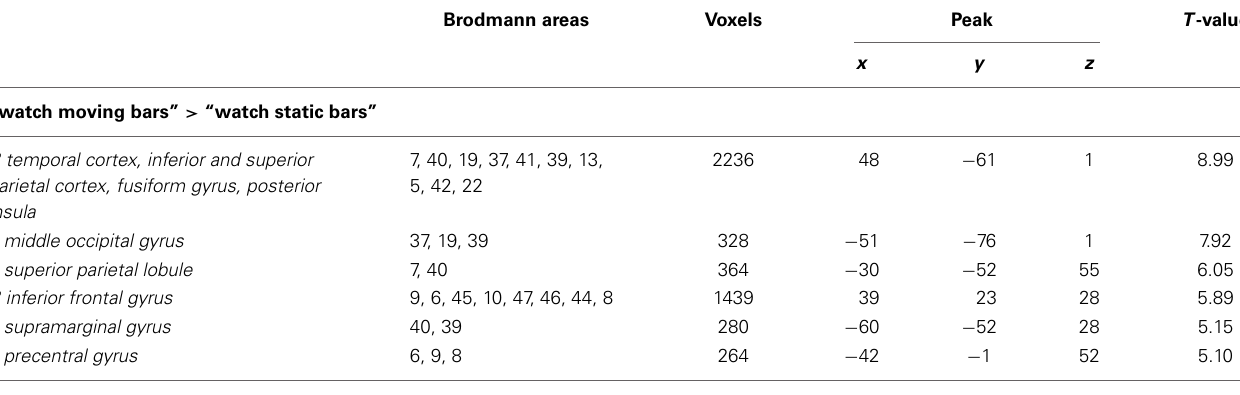
“watch static bars” > “watch moving bars” No significant activation cluster Reported coordinates in MNI space; L, left; R, right; p < 0.001 uncorrected on voxel-level, p < 0.05 corrected for multiple comparisons on cluster-level